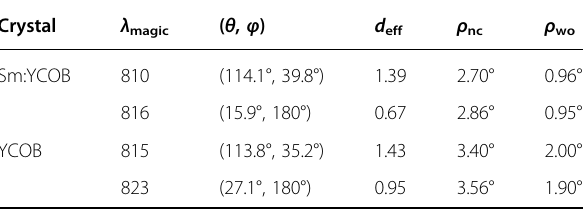
Table 2 Crystal speci fi cations of Sm:YCOB and YCOB under magic phase matching and a 532-nm pump